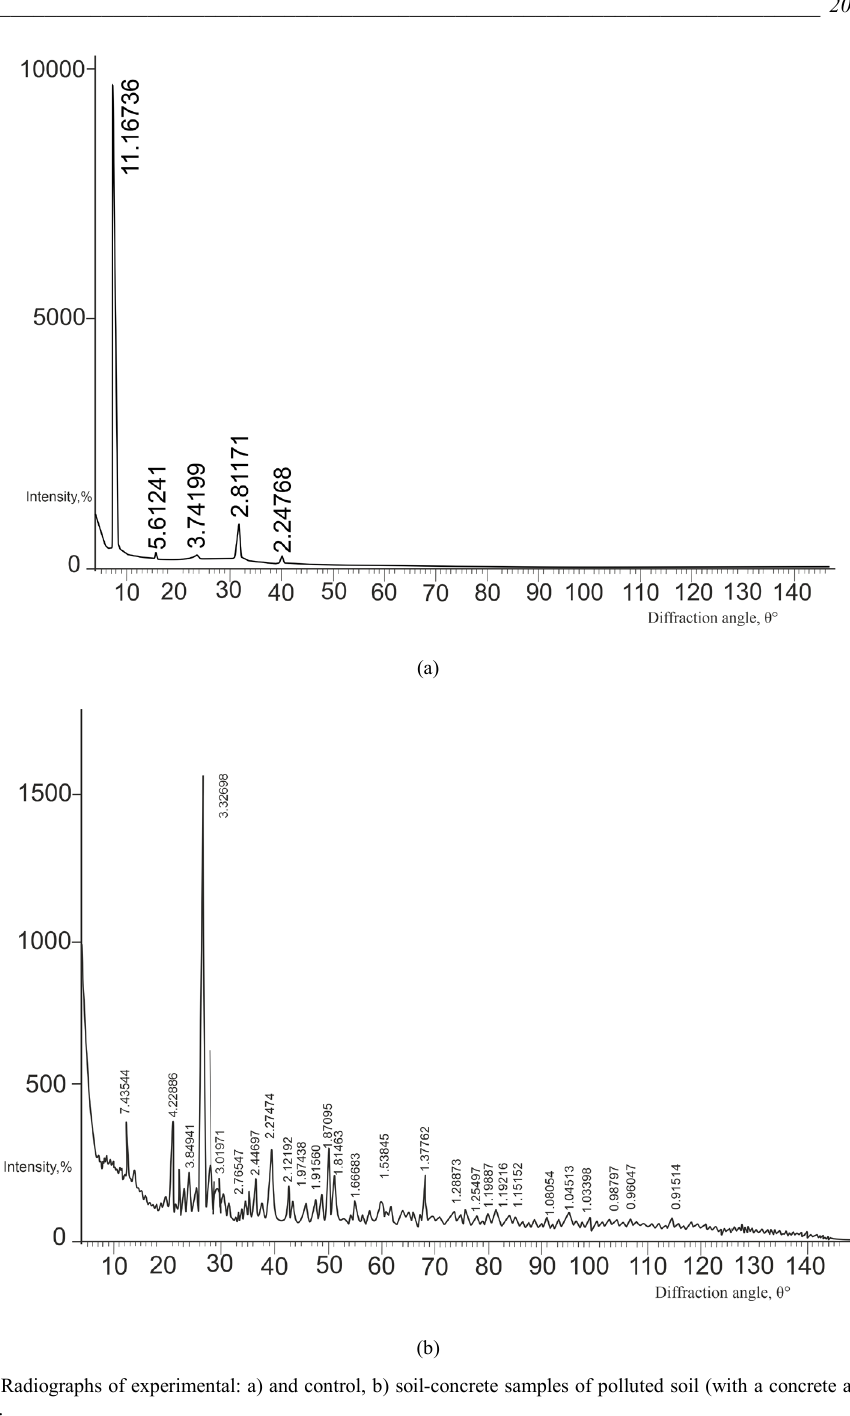
Fig. 5. Radiographs of experimental : a) and control , b) soil - concrete samples of polluted soil (with a concrete additive)